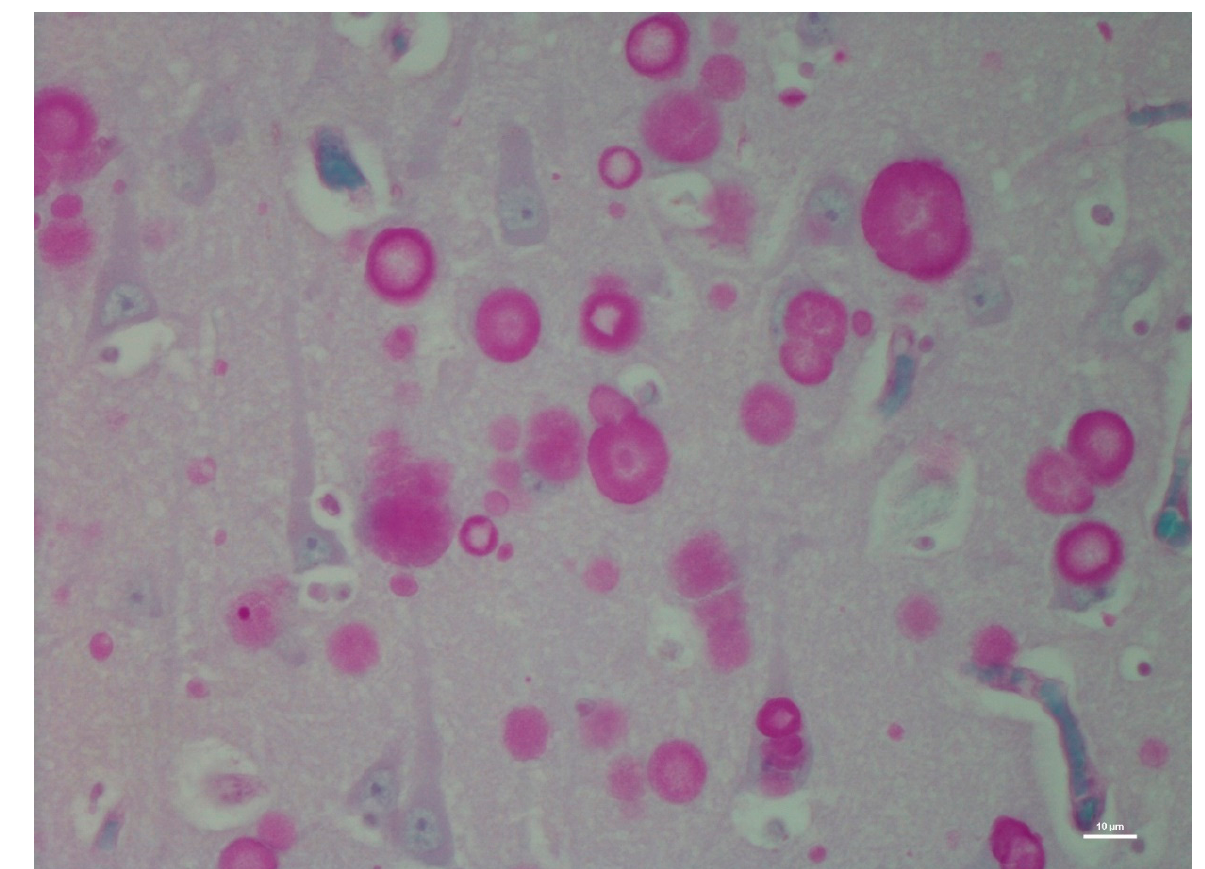
Figure 2. Periodic acid-Schiff (PAS)-stained section of the hippocampus region of the brain of the same moose showing round polyglucosan (Lafora) bodies.